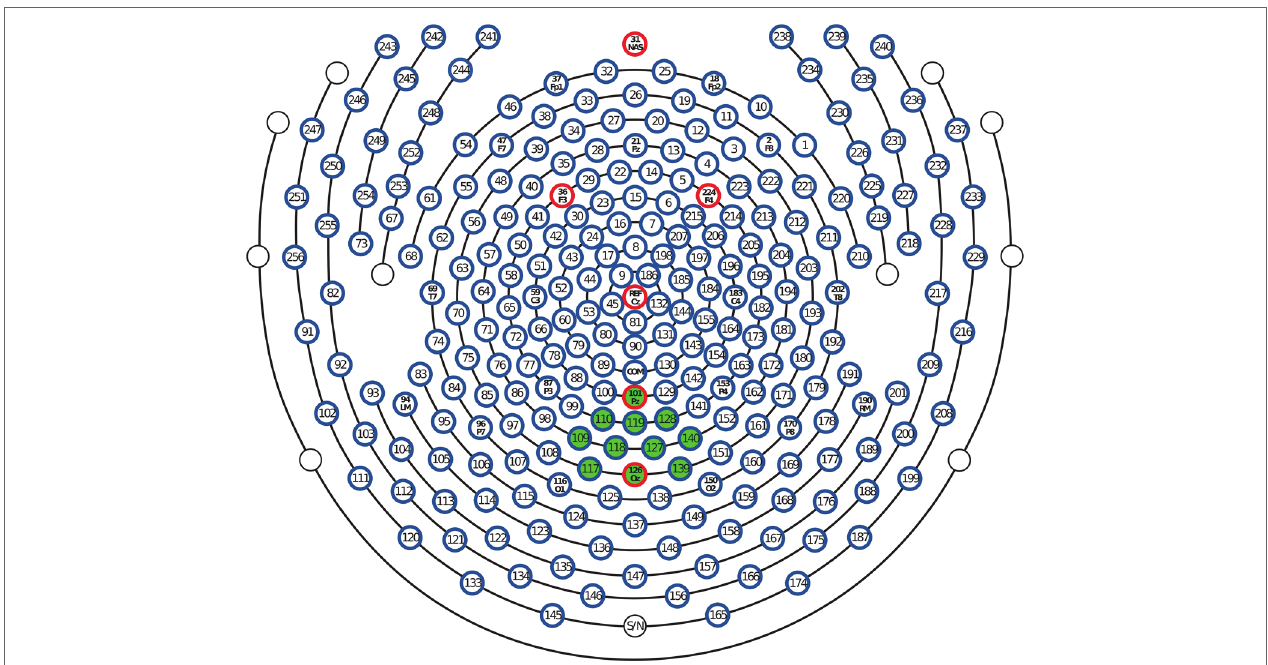
FIGURE 2 | Layout of the 257-sensor array. Posterior electrodes are shown at the bottom of the figure. Green-shaded electrode sites, including Pz and Oz, were selected to form occipital regional means entering frequentist and Bayesian statistical